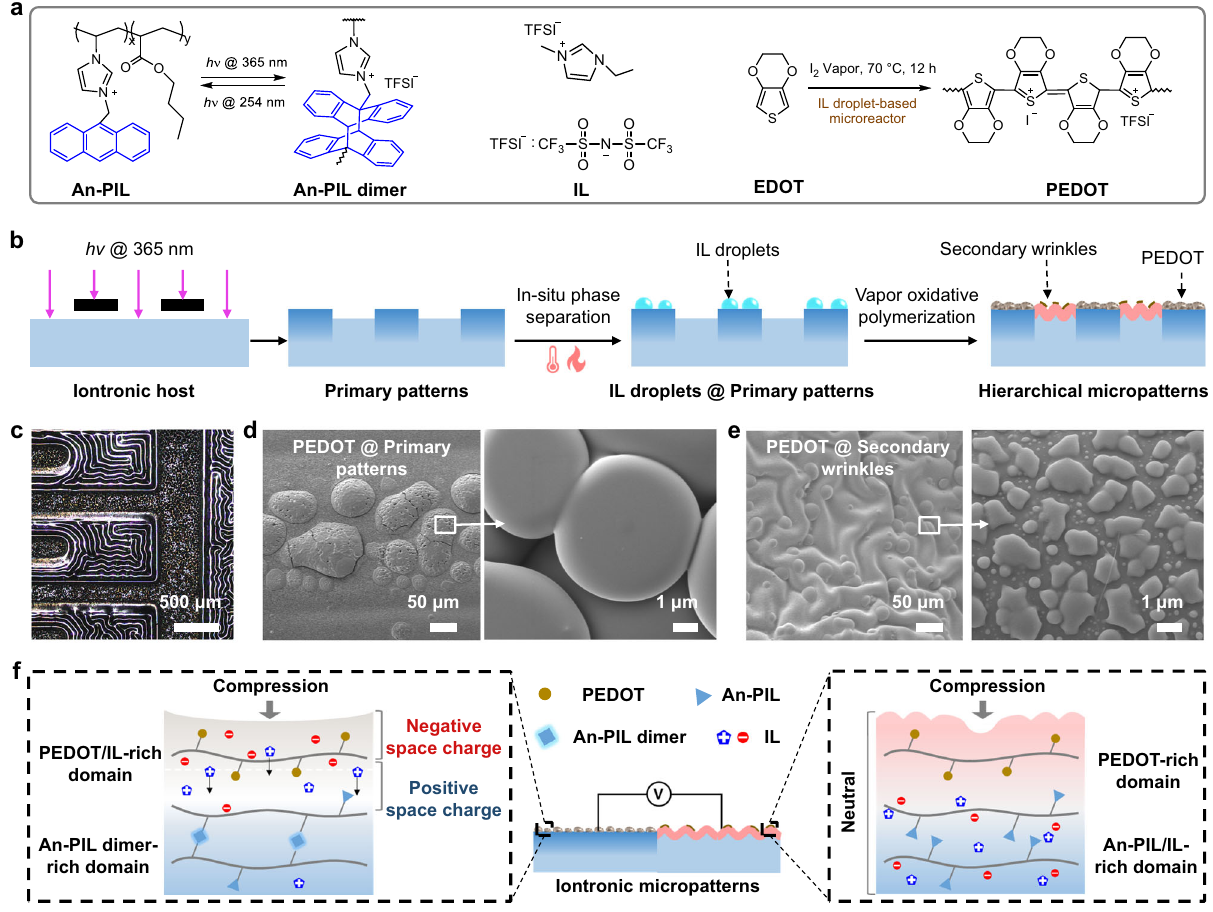
Fig. 1 | Design, structure, and piezoionic effect of a HAIM. a Chemical structure of An-PIL, An-PIL dimer, IL, and PEDOT. b Schematic of the fabrication process for HAIMs through localized photodimerization, heating (to drive in-situ phase separation), and vapor oxidative polymerization. c Microscope images of a